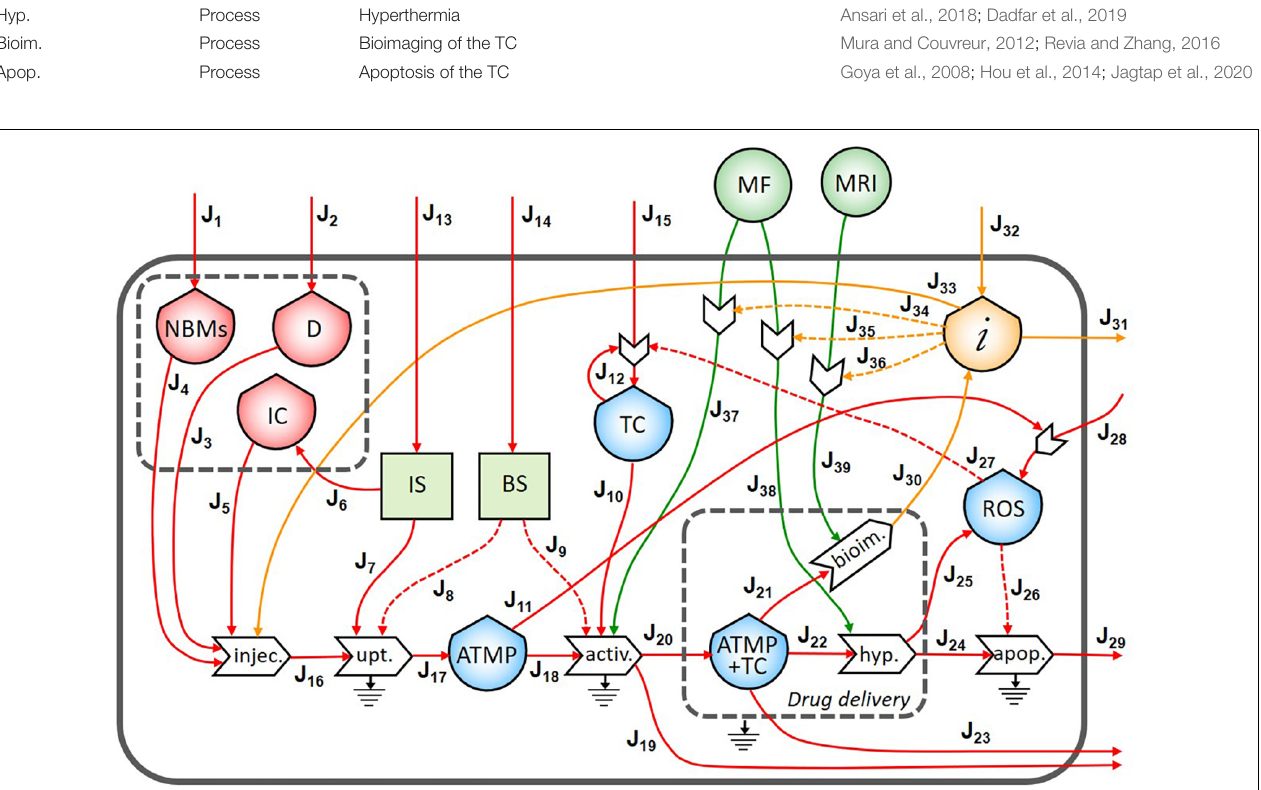
FIGURE 3 | Representation of the theranostic approach of the magnetite nano-biomaterials (NBMs) to solid tumor.